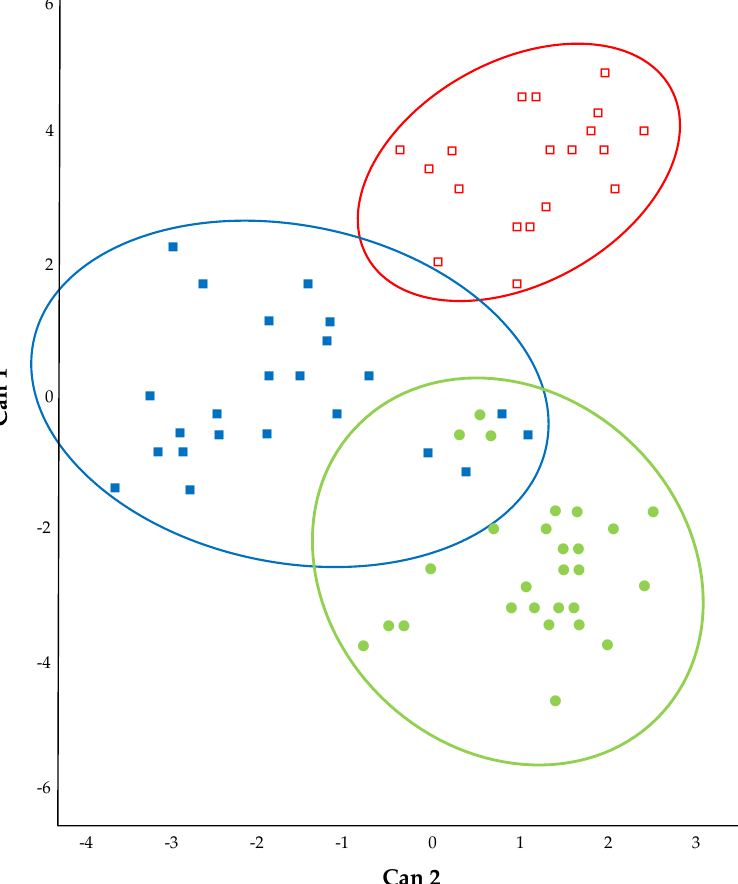
Figure 2. Plot of Canonical 1 × Canonical 2 – variable: microbial loads of wooden shelves ’ biofilm. ▪, wooden shelves used for the ripening of TAP Caciocavallo Palermitano cheese; ●, wooden shelves used for the ripening of PDO Pecorino Siciliano cheese; ▫, wooden shelves used for the ripening of Piacentinu Ennese cheese. Centroids coordinates: ▪ (0.04; −1.90); ● (−2.5; 0.93); ▫ (3.46; 0.97).